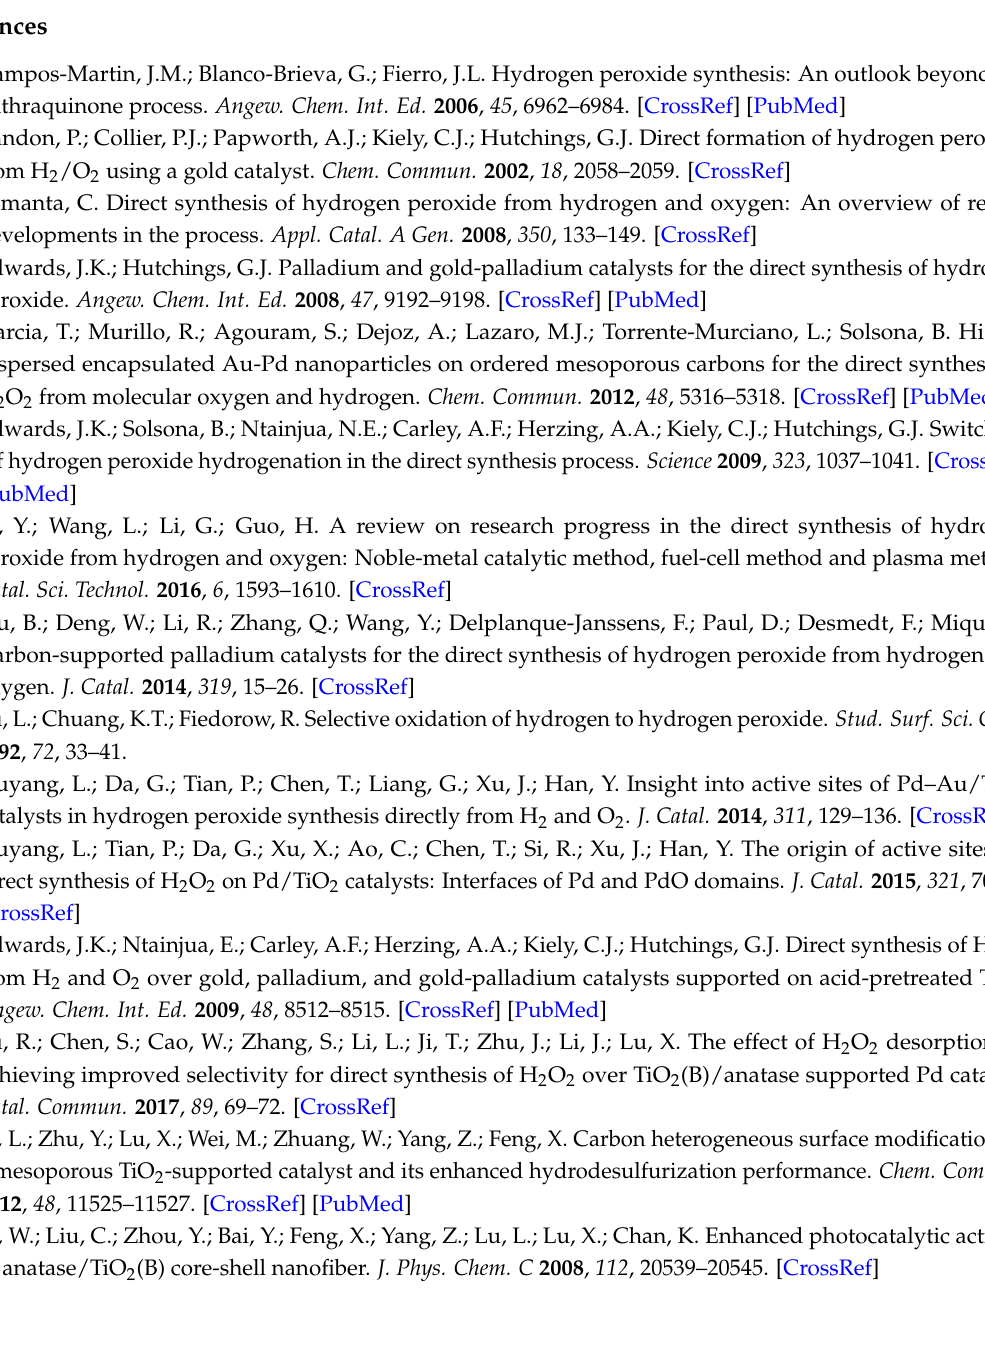
Figure S3: The scheme of reaction process, Table S1: Quantified XPS data for the surface Pd atoms, Table S2: Calorimetric measurement of H 2 O 2 adsorption, Table S3: The performance of Pd catalysts for H 2 O 2 synthesis, decomposition and